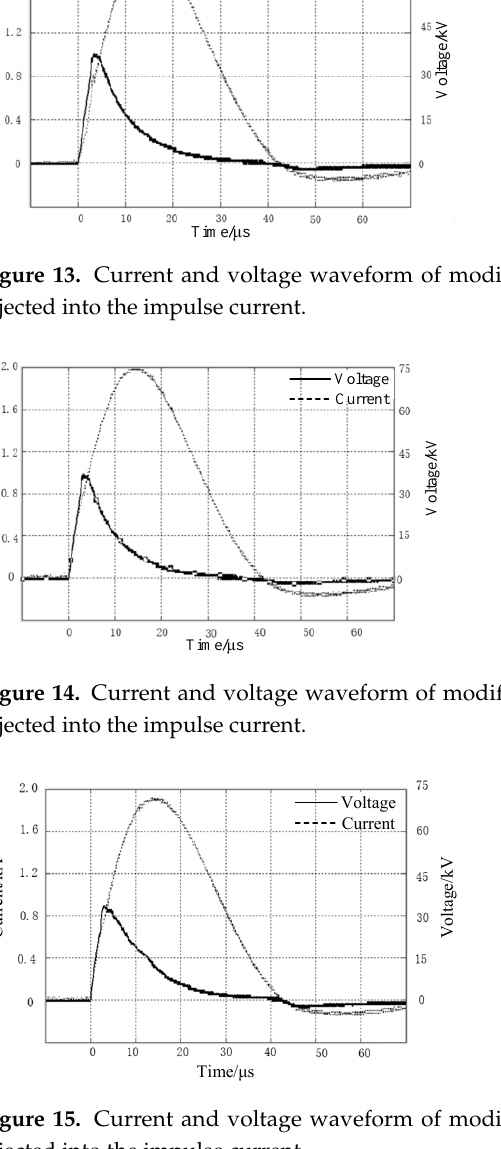
Figure 15. Current and voltage waveform of modified soil with the SAP content of 0.5% when injected into the impulse current.